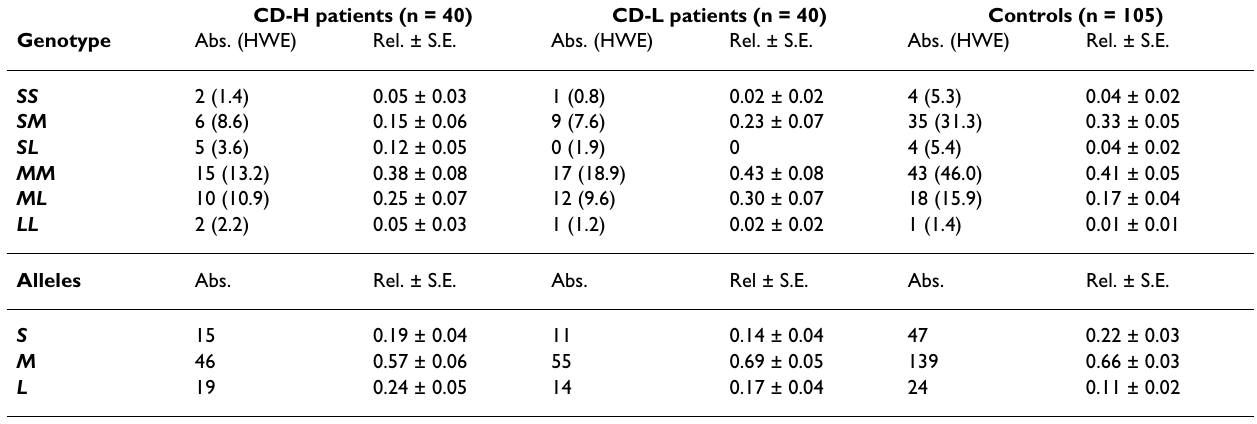
Table 6: 3'APOB-VNTR absolute (Abs.) and Relative (Rel.) genotypic and allelic frequencies (± Standard Error) in CD-H and CD-L patients and in sex and age matched controls (males; 46–80 year age range). Values expected at Hardy-Weinberg equilibrium (HWE) are in parenthesis. Alleles: S < 35 repeats; M 35–39 repeats; L >39